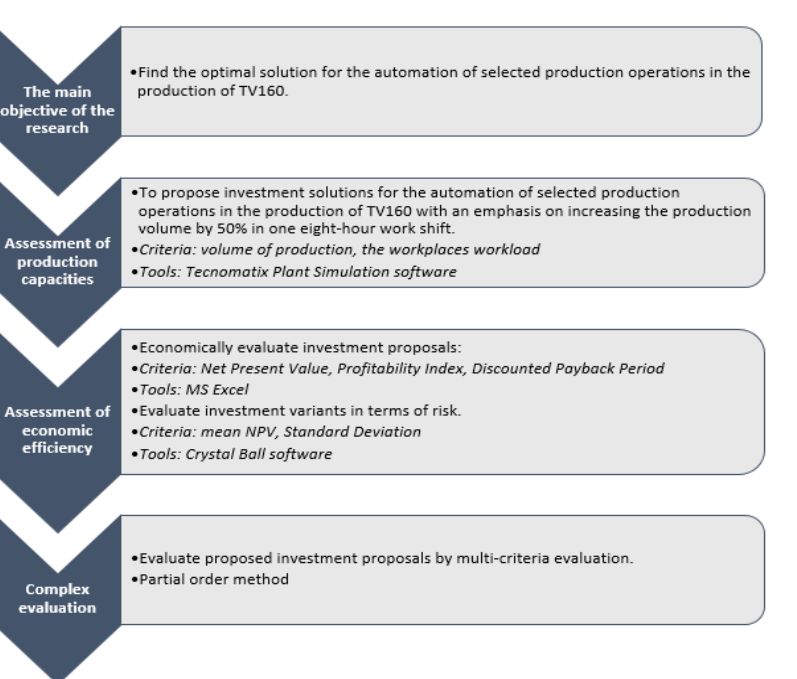
Figure 3. Procedure for defined problem solving.